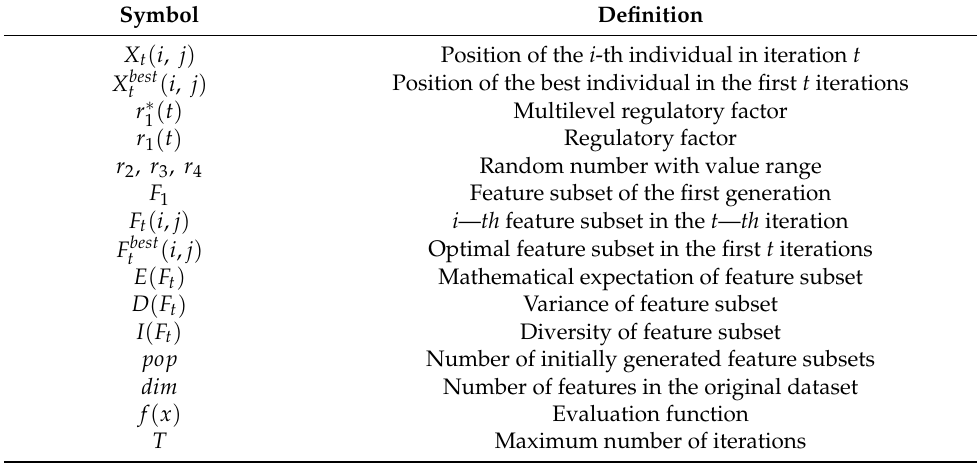
Table 1. Symbols and their